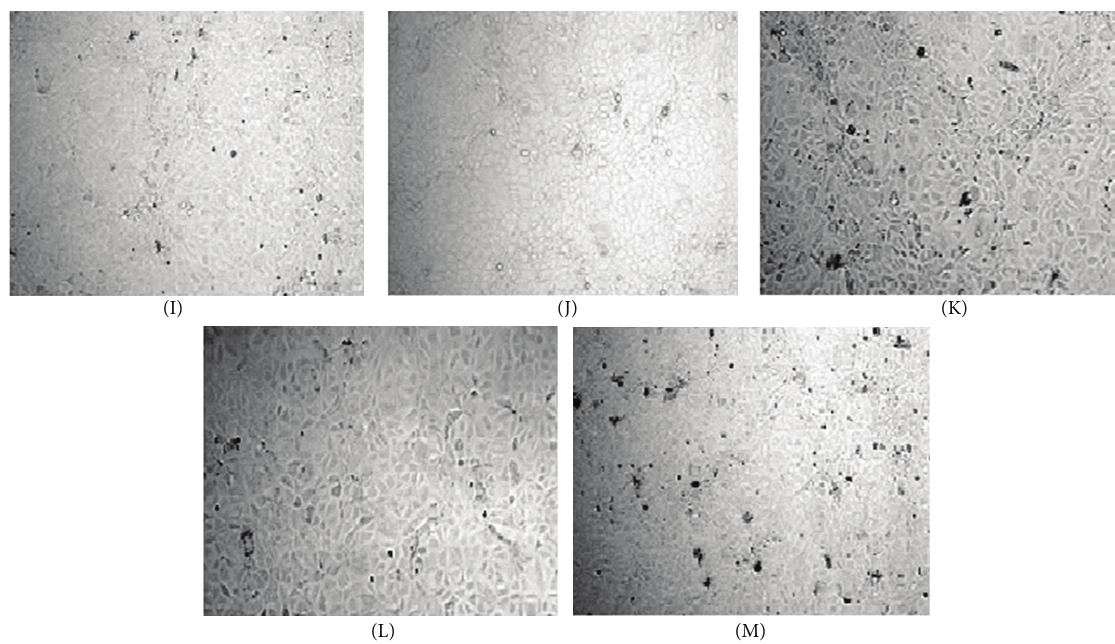
Figure 2: Effect of IC 50 (based on MTT assay) values of HWE, CWE, MWE, AWE, EAA, AAA, PAE, AAE, MAE, 30 C, and MT of Ruta and 5-FU on cell growth of NRK-52E cells after treatment period of 48 hours. (A) Control (untreated); (B) 5-FU; (C) HWE; (D) CWE; (E) MWE; (F) AWE; (G) EAA; (H) AAA; (I) PAE; (J) AAE; (K) MAE; (L) 30 C; (M) MT after 48 hours treatment (magnification at